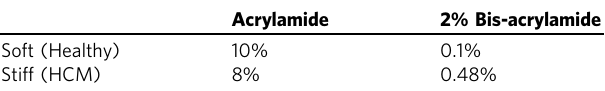
Table 1 Pre-polymer solution